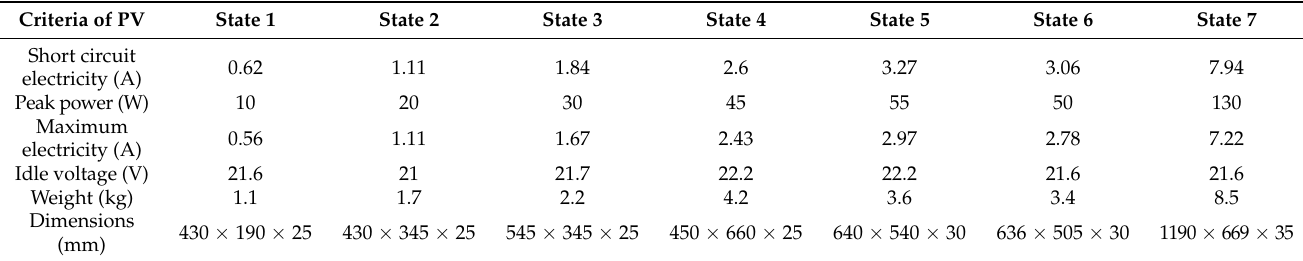
Table 1. States of PV